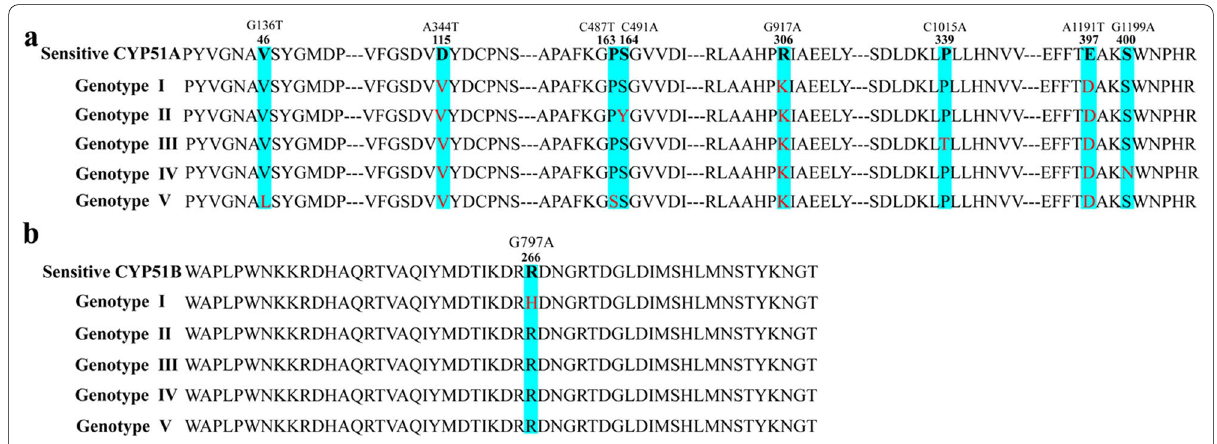
Fig. 2 Sequence alignment of CYP51A ( a ) and CYP51B ( b ) from tebuconazole-sensitive and tebuconazole-resistant isolates of Colletotrichum siamense . The amino acid mutations in CYP51A and CYP51B from the tebuconazole-resistant isolates are marked in